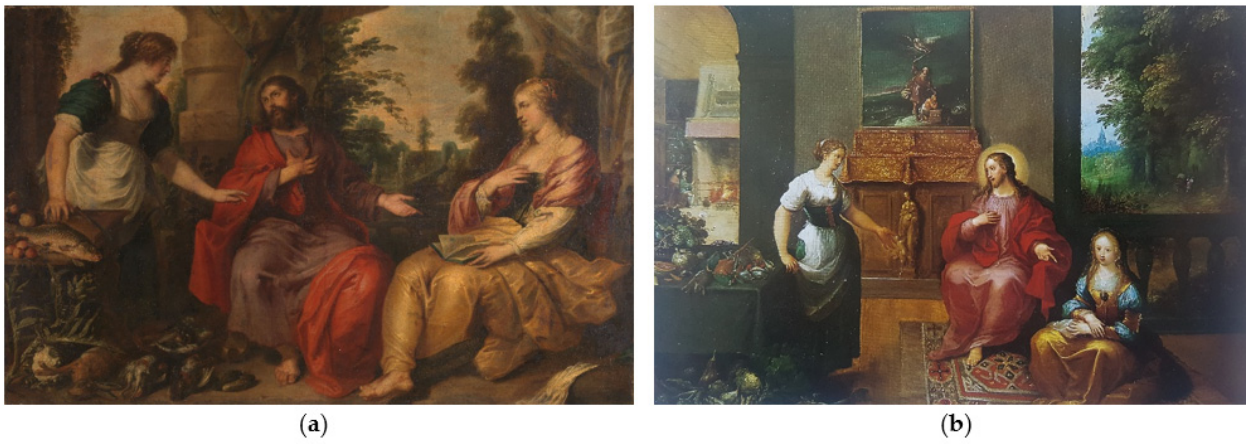
Figure 2. ( a ) Vincent Malò, Christ with Martha and Mary , c. 1630–c. 1634, oil on canvas, 147.4 × 230.5 cm. Credit line: Rijksmuseum. ( b ) Frans Francken II, Christ with Martha and Mary , c. 1620, oil on panel, 57 × 76 cm. Private collection. Credit line: Ha ̈ rting, Ursula Alice. Frans Francken der Ju ̈ ngere (1581–1642): die Gema ̈ lde mit kritischem Oeuvrekatalog. 1989.